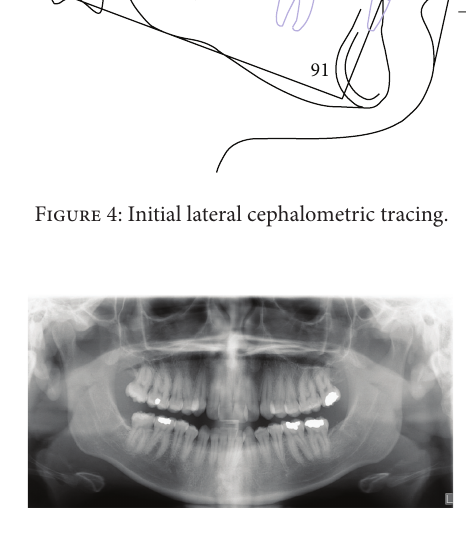
Figure 5: Initial panoramic radiograph.